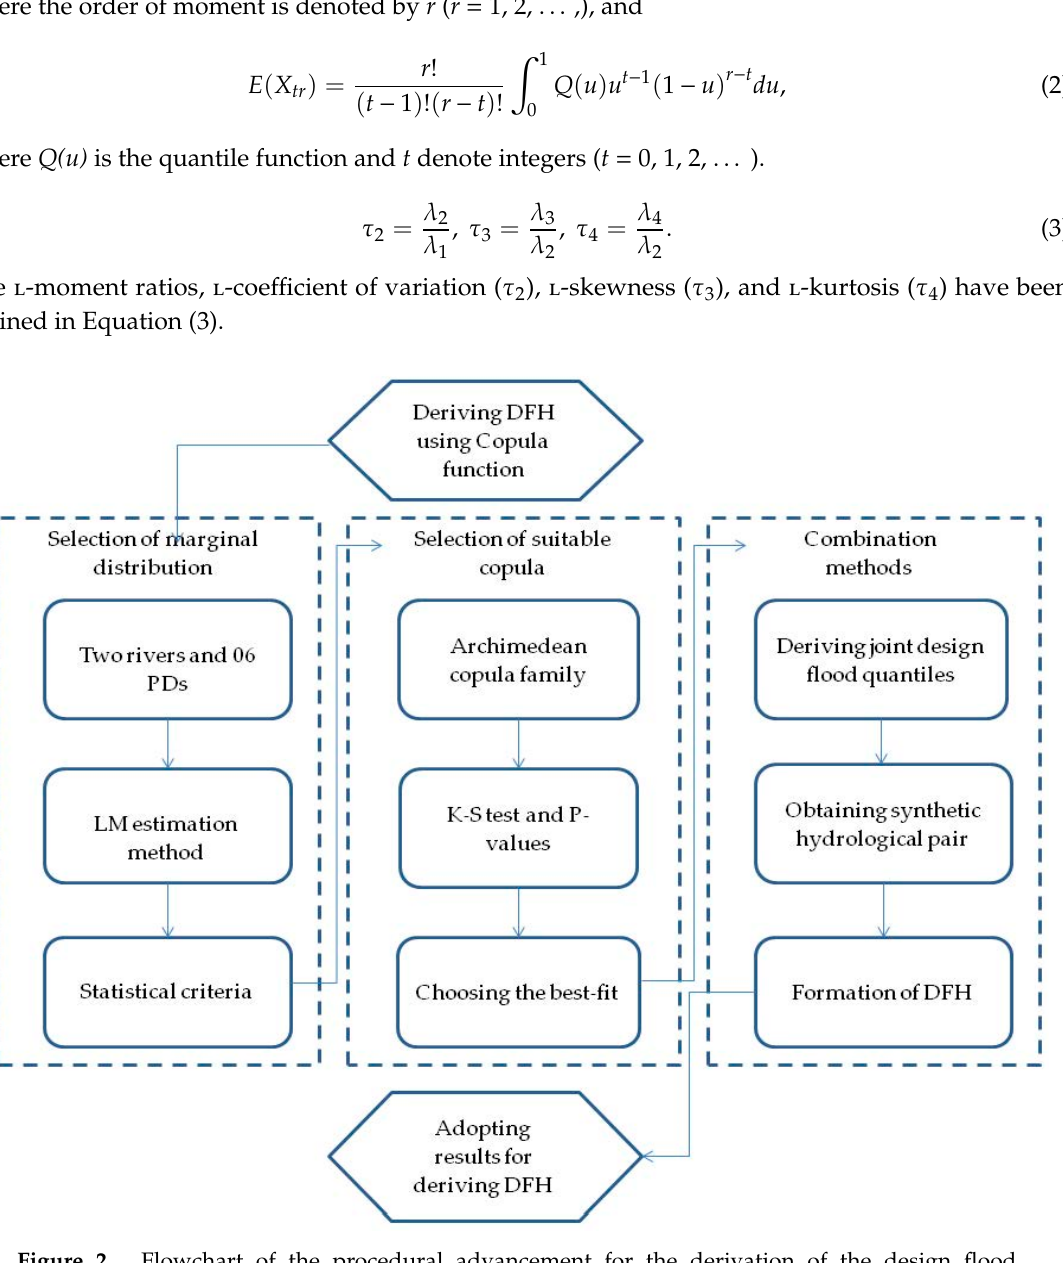
Figure 2. Flowchart of the procedural advancement for the derivation of the design flood hydrograph